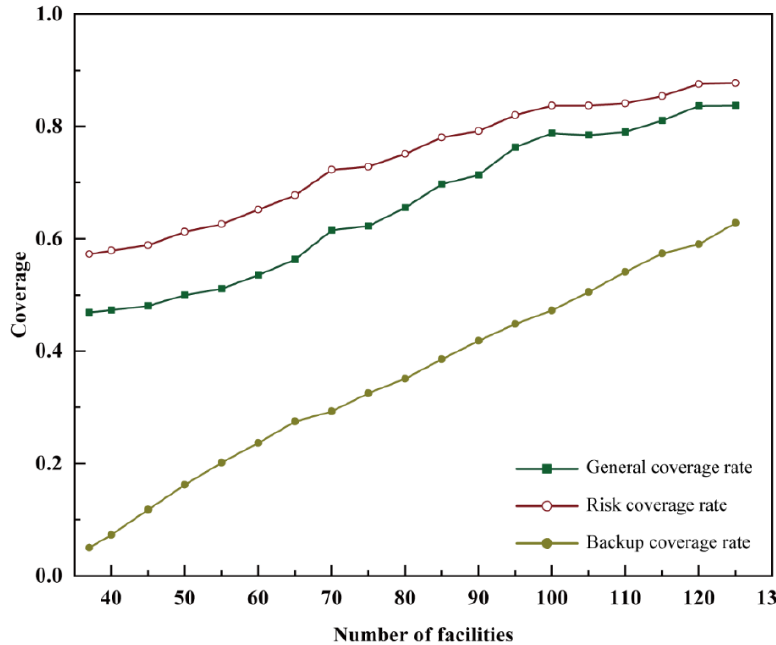
Figure 8. Number of facilities and coverage using the backup coverage model (BCM).